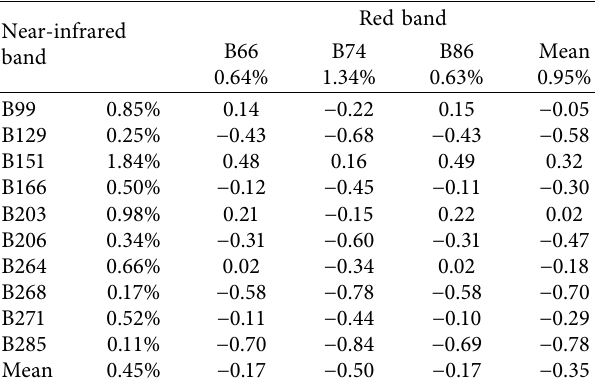
Table 4: NDVI values of characteristic bands in Caohai. Near-infrared band